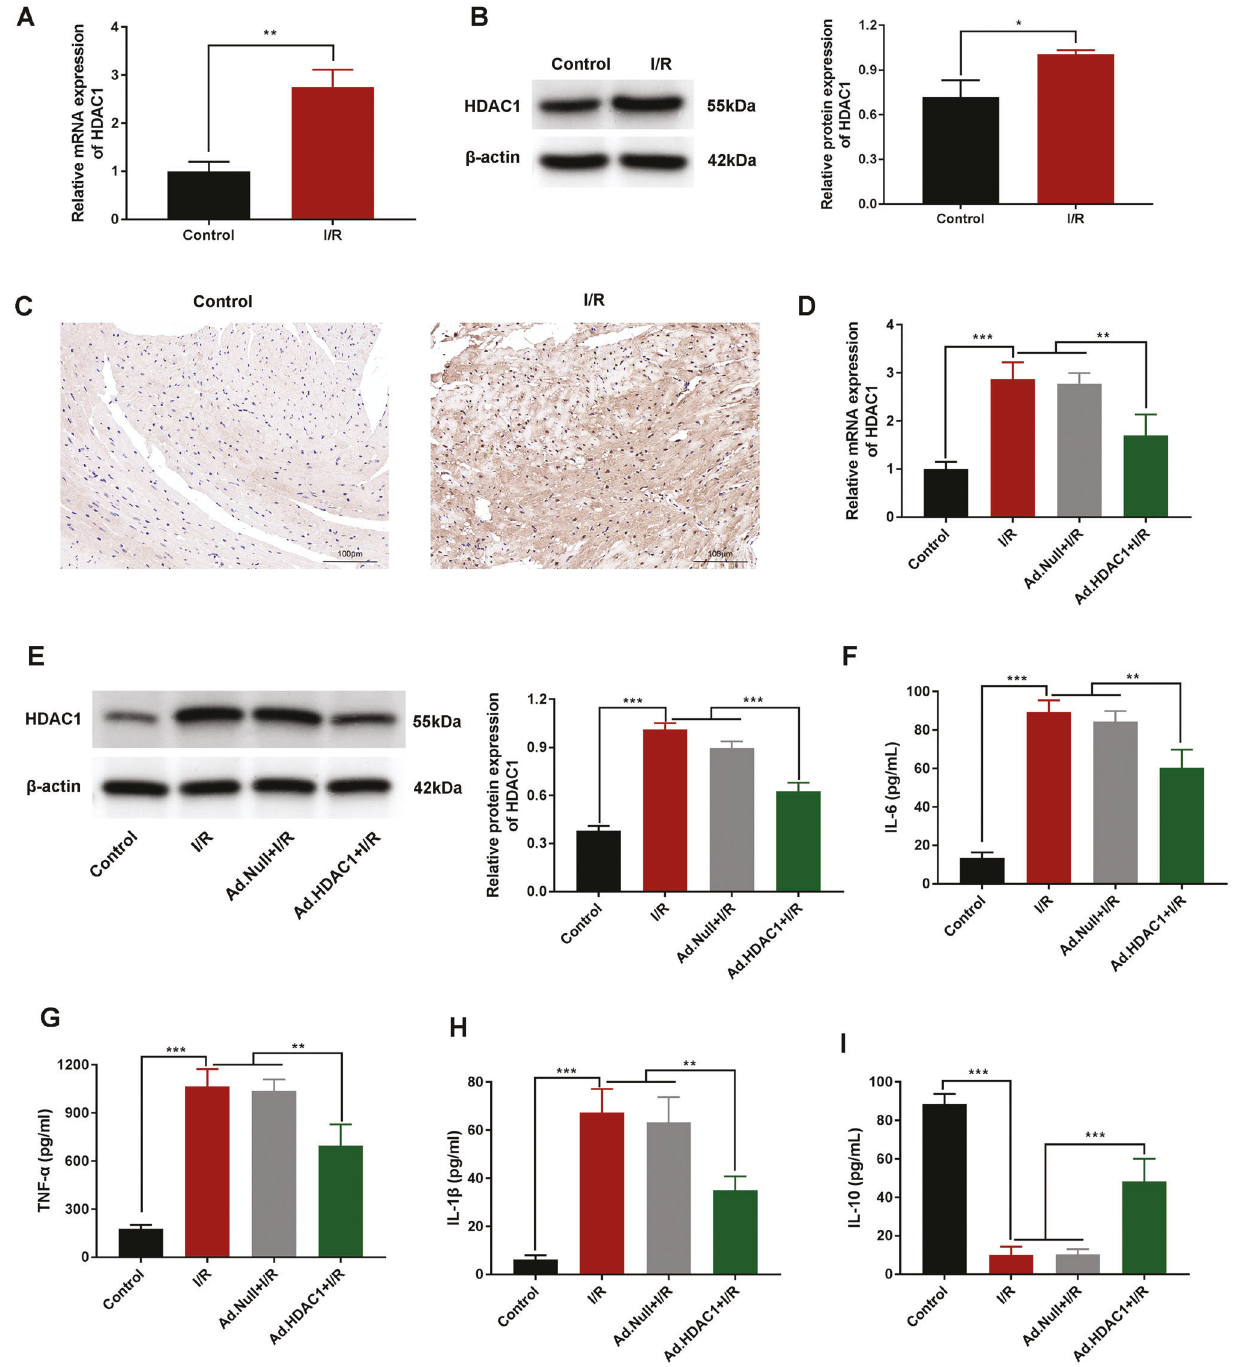
Fig. 1 HDAC1 promotes in fl ammation post-I/R. A qRT-PCR analysis of HDAC1 mRNA in control and I/R mice. B HDAC1 expression determined via western blotting. C HDAC1 expression in the infarct area analyzed by IHC. D qRT-PCR and E western blot analysis of HDAC1 expression in I/R mice injected with HDAC1-silencing adenovirus HDAC1 (Ad.HDAC1). F – I IL-6, TNF-a, IL-1 β , and IL-10 levels in the supernatants of I/R mice assessed via ELISA. Data are the mean ± SD, n = 3; ** P < 0.01. *** P < 0.001. Inhibition of HDAC1 improves H/R-induced macrophage Ad groups. The Null + I/R group showed no difference to the I/R in fl ammatory responses group. IL-6, TNF-a, and IL-1 β concentrations were lower in the Ad- We constructed an in vitro H/R injury model in RAW264.3 cells HDAC1 + I/R group compared to the I/R group ( P < 0.01, P < 0.001) (hypoxia, 8 h; reoxygenation, 16 h). As shown in Fig. 2A, B, (Fig. 1F – H). In contrast, the levels of IL-10 in I/R mice were RAW264.3 cells in the H/R group showed higher HDAC1 signi fi cantly lower than the control group, but increased in the Ad- expression compared to the control group ( P < 0.001). HDAC1 HDAC1 + I/R group ( P < 0.01, P < 0.001; Fig. 1I). These results levels were signi fi cantly lower in H/R mice treated with con fi rmed that HDAC1 promotes in fl ammation in I/R mouse models. Cell Death Discovery (2023)